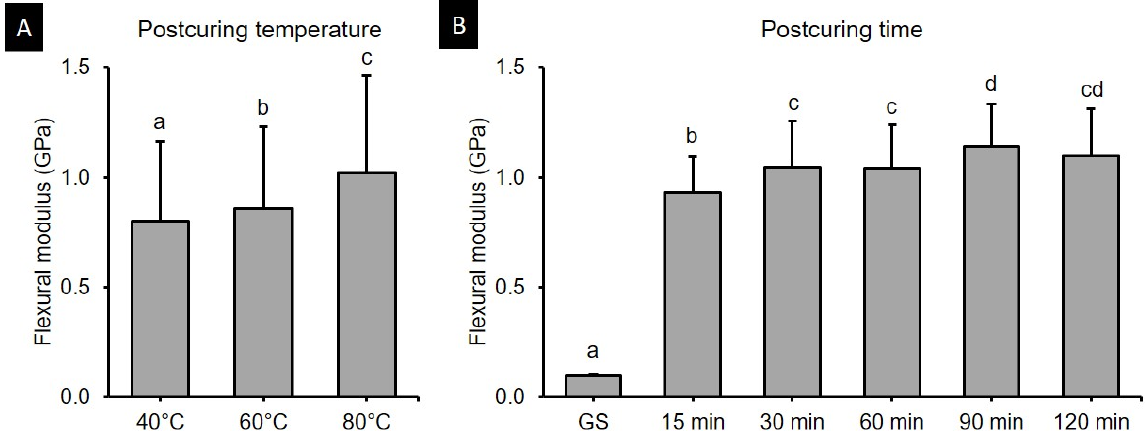
Figure 5. Results from two-way ANOVA. Flexural modulus data according to ( A ) postcuring temperature and ( B ) time. Data are mean and standard-deviation values. Different lowercase letters indicate a significant difference.